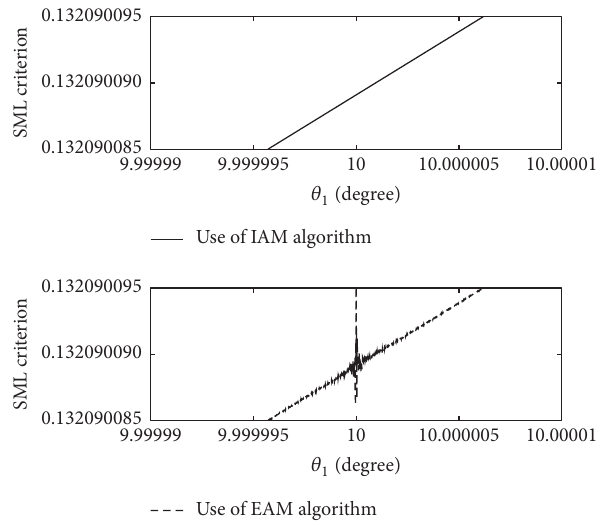
Table 1: Comparison of computational complexity of AM, EAM, and IAM. The scenario is the same as Figure 5 when SNR = 5